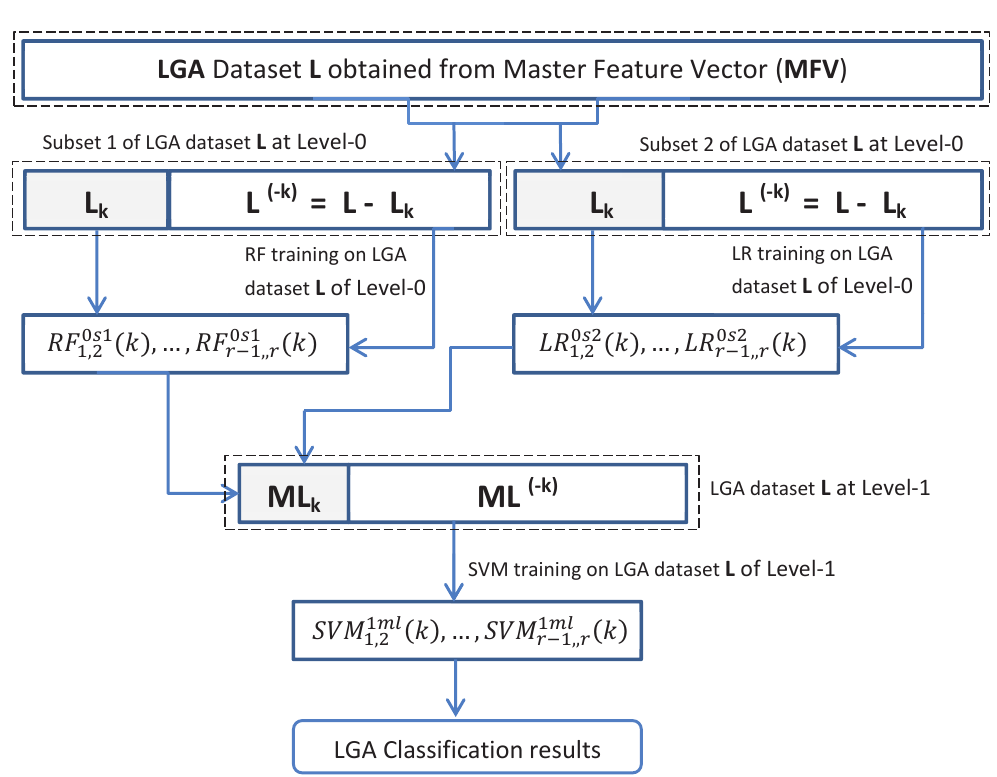
Figure 3. The complete classification procedure of proposed stacking scheme with the creation of meta-level training dataset at level-0 and level-1 of the stacking